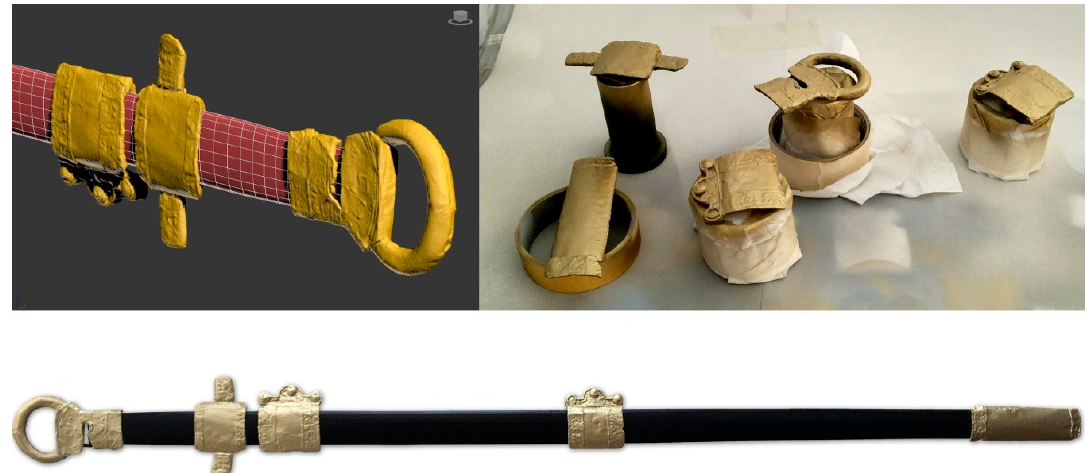
Figure 28. 3D printing of the Kunàgota sword: Mesh optimization; 3D printing of the models and spraying; completed physical replica of the sword.